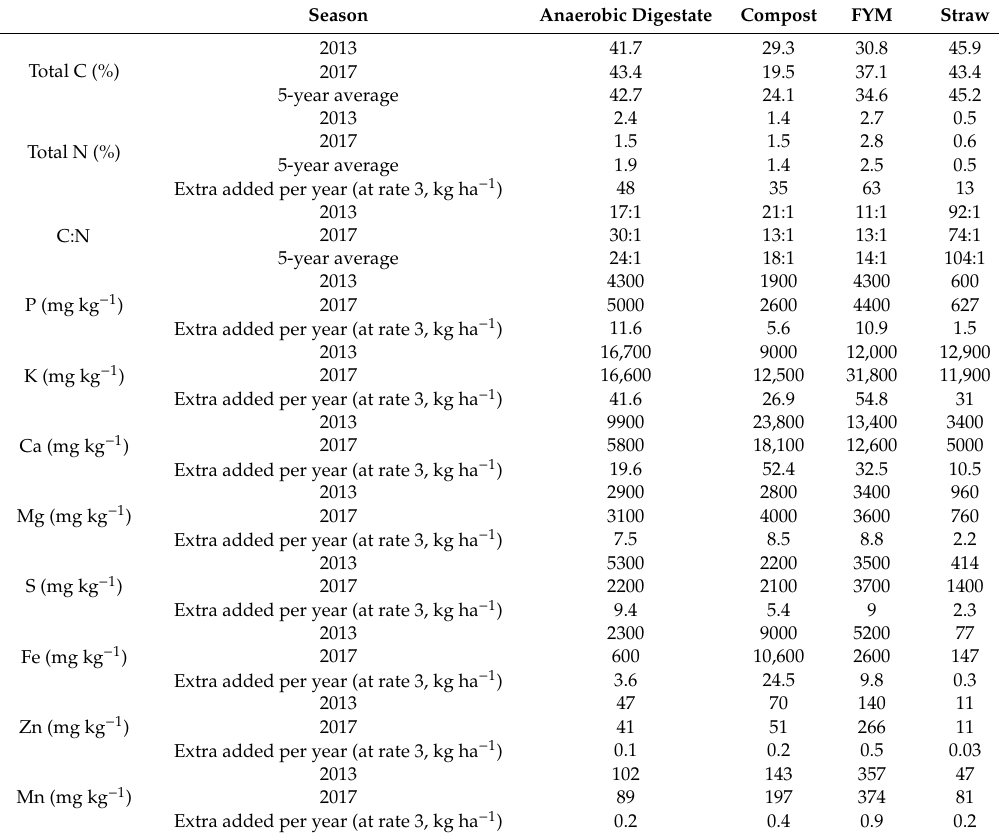
Table 1. Total C and N and C:N ratio, and macro and micro nutrient concentration (measured using pXRF) of the amendments: anaerobic digestate, compost, FYM and straw, in the baseline season (2013), after 5 seasons (2017), and as an average of the analyses from each of the 5 seasons.